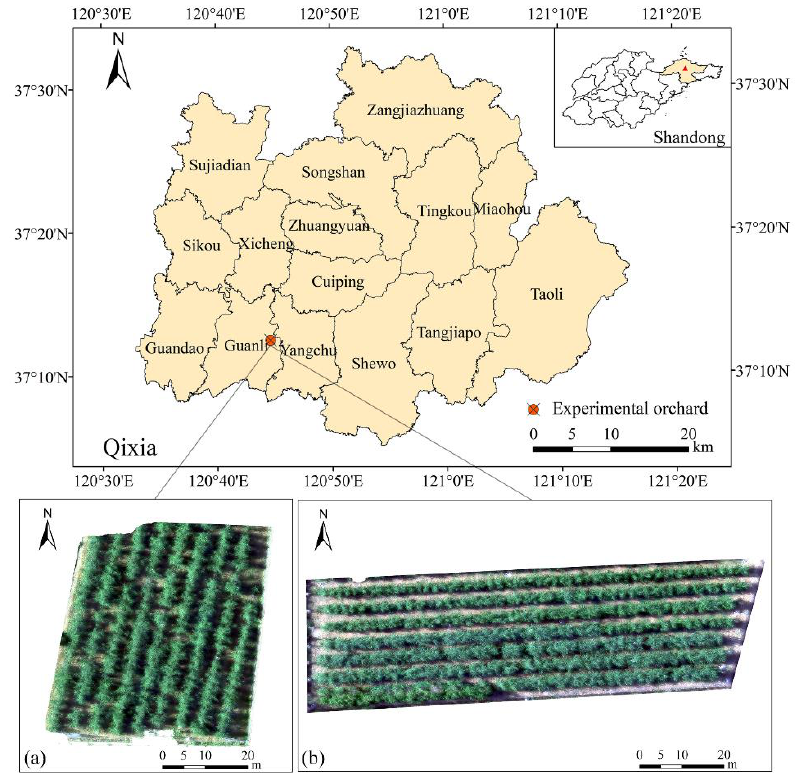
Figure 1. Study area and distribution of sample areas orchards ( a , b ). The images of experimental orchards were captured by a UAV and displayed in true color (R 650 , R 562 , R 482 ).